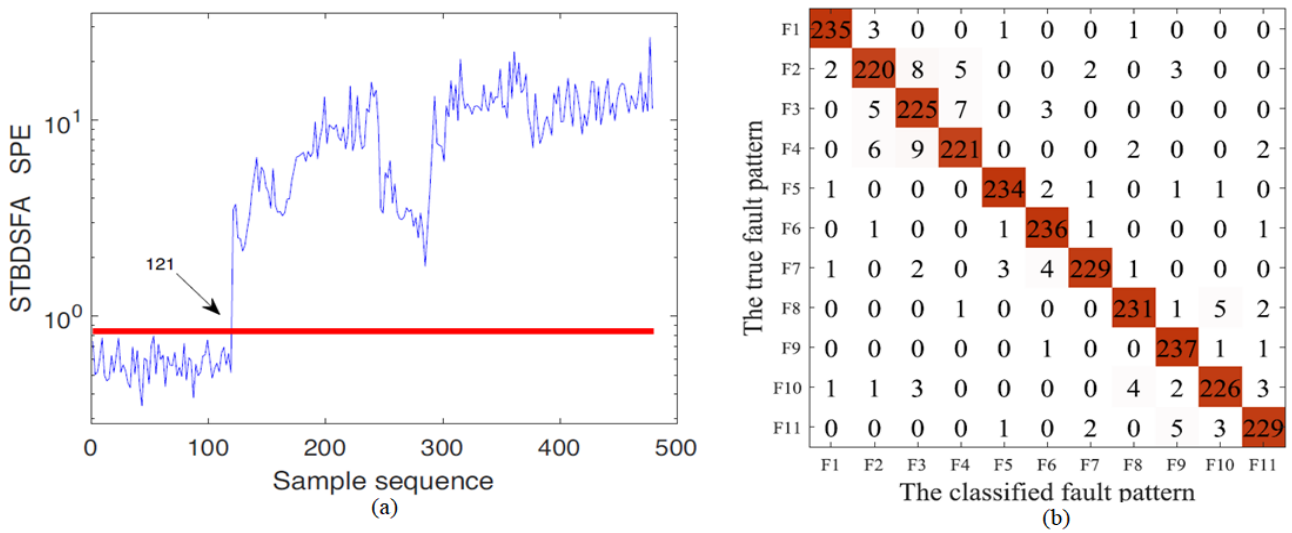
Figure 42. ( a ) Monitoring chart for the diagnosis of bearing fault by employing STBDSFA to detect fault at the 121st point in the total of 500 samples. ( b ) Confusion matrix plot for bearing faults classification [113].